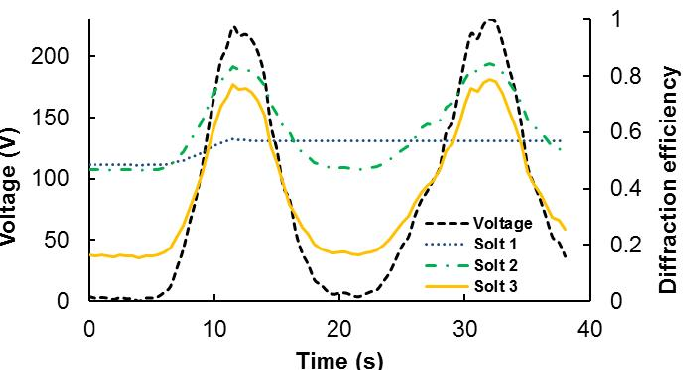
Figure 5. TE dependence from the applied voltage for the different chemical compositions Solt 0; Solt 1; Solt 2 and Solt 3.